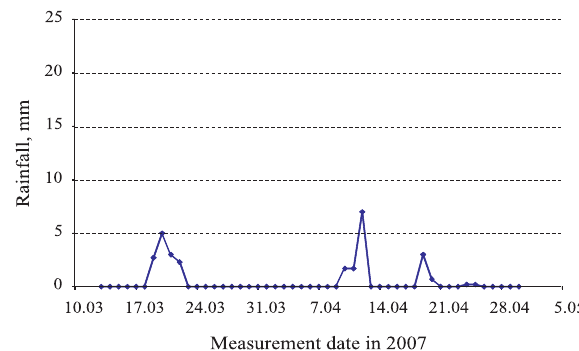
Fig. 4. Average daily precipitation on the plant site in the AMP Benninghoven in 2007